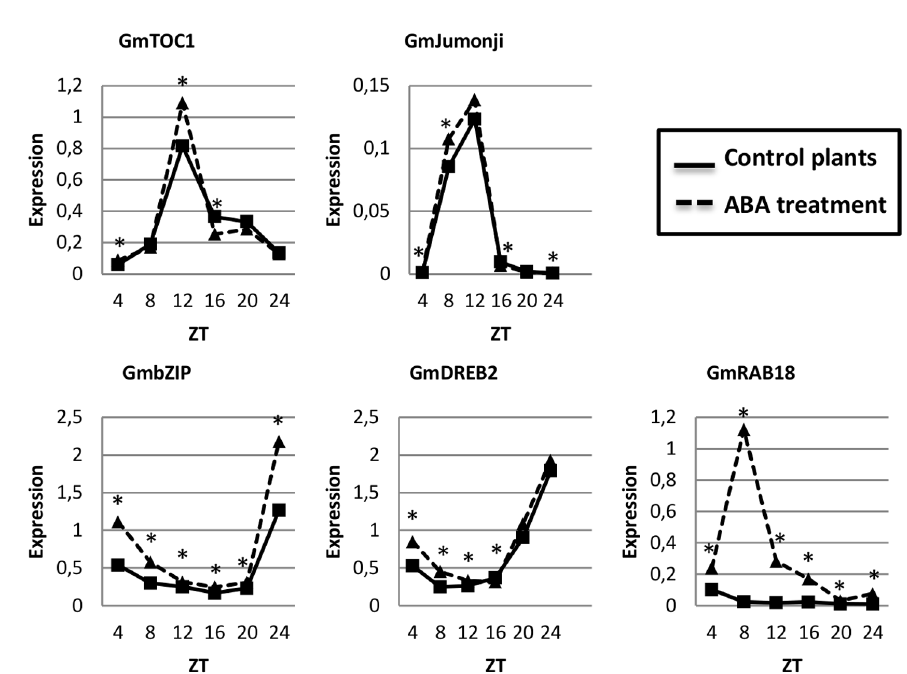
Figure 4. ABA treatment affects the regulation of drought-responsive and some circadian clock genes. Gene expression data regards qPCR analysis of circadian clock (A) and drought-responsive (B) genes. Expression axis represents normalized expression (NE)=2^ -(Ct experimental – Ctn) . Collect time points are represented by ZT (Zeitgeiber Time) 4 to 24, starting 4h after the lights came on ( ZT4) and proceeding with 4 h intervals until ZT24. For easy viewing, asterisks represent significant differences between control and stressed plants in each time point (Duncan’s test 5%, time - treatment interaction). The ANOVA and the complete Duncan’s tests results can be found in Table S5.